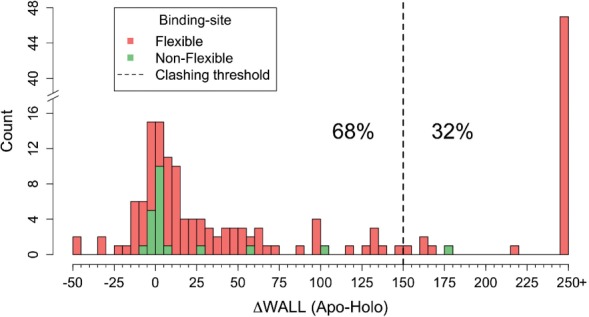
Differences in steric potential (WALL) between Apo-bound and Holo forms. Positive values represent cases where the Apo-bound form is less sterically favorable than the Holo. For clarity purposes, we cap the minimum to −50 and maximum to 250. The empirical threshold value (dashed line) was selected upon visual inspection of all cases in its vicinity